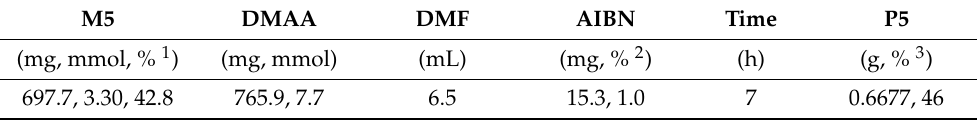
Table 1. Experimental data of copolymerization of M5 with